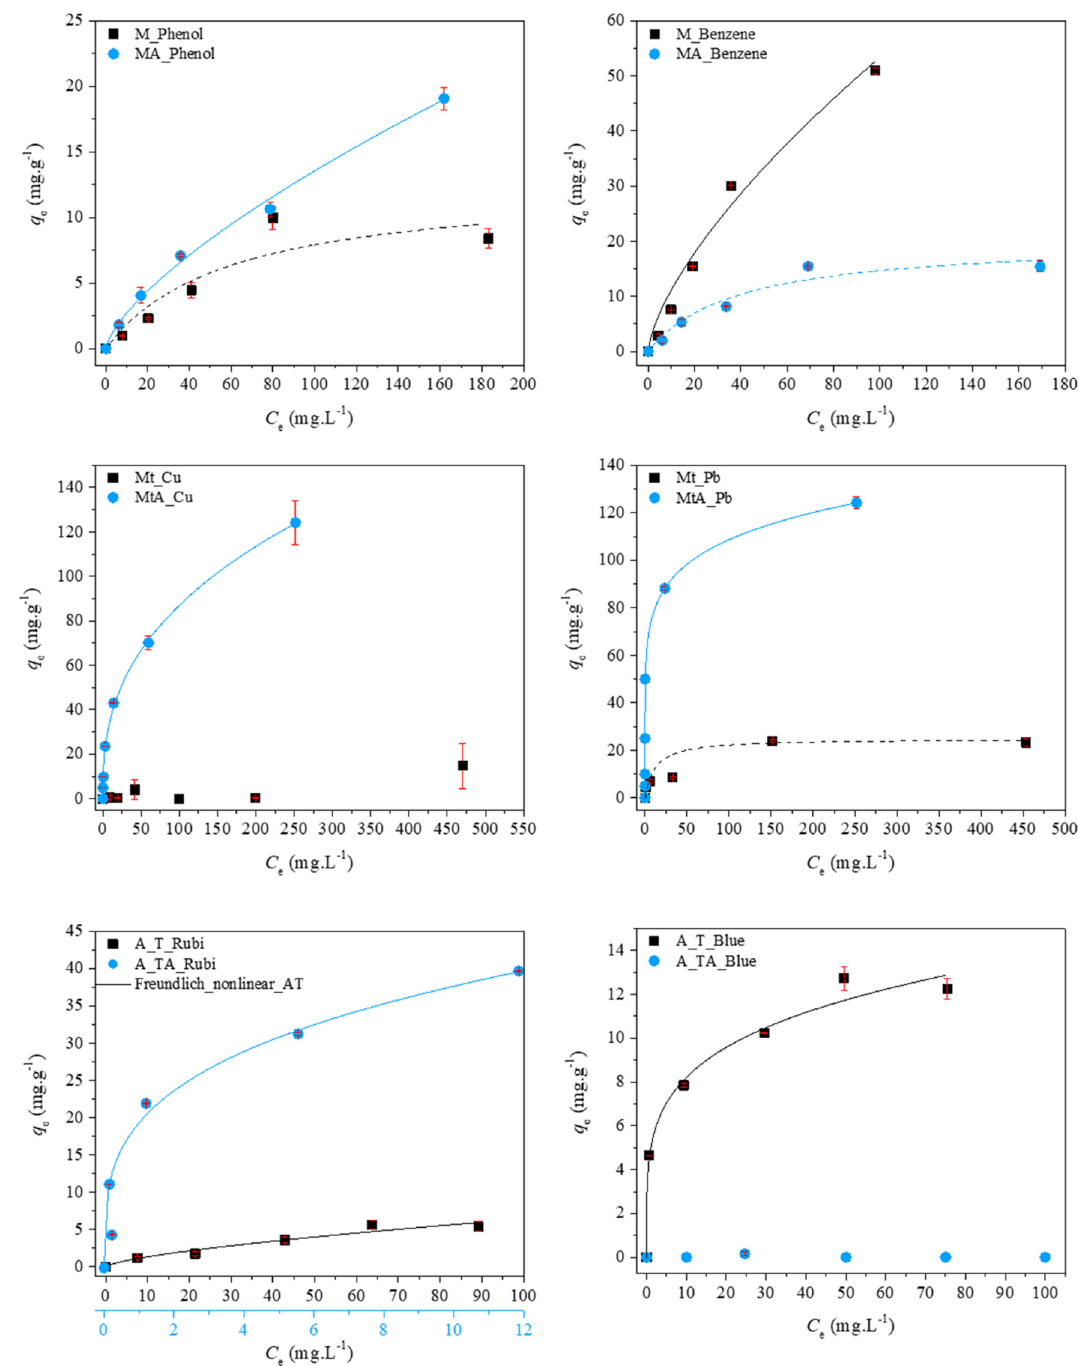
Figure 2. Experimental equilibrium data and the best fitted isotherm model for adsorption of the pollutants into the studied aerogels and xerogels. (dashed line—Langmuir; solid line—Freundlich).